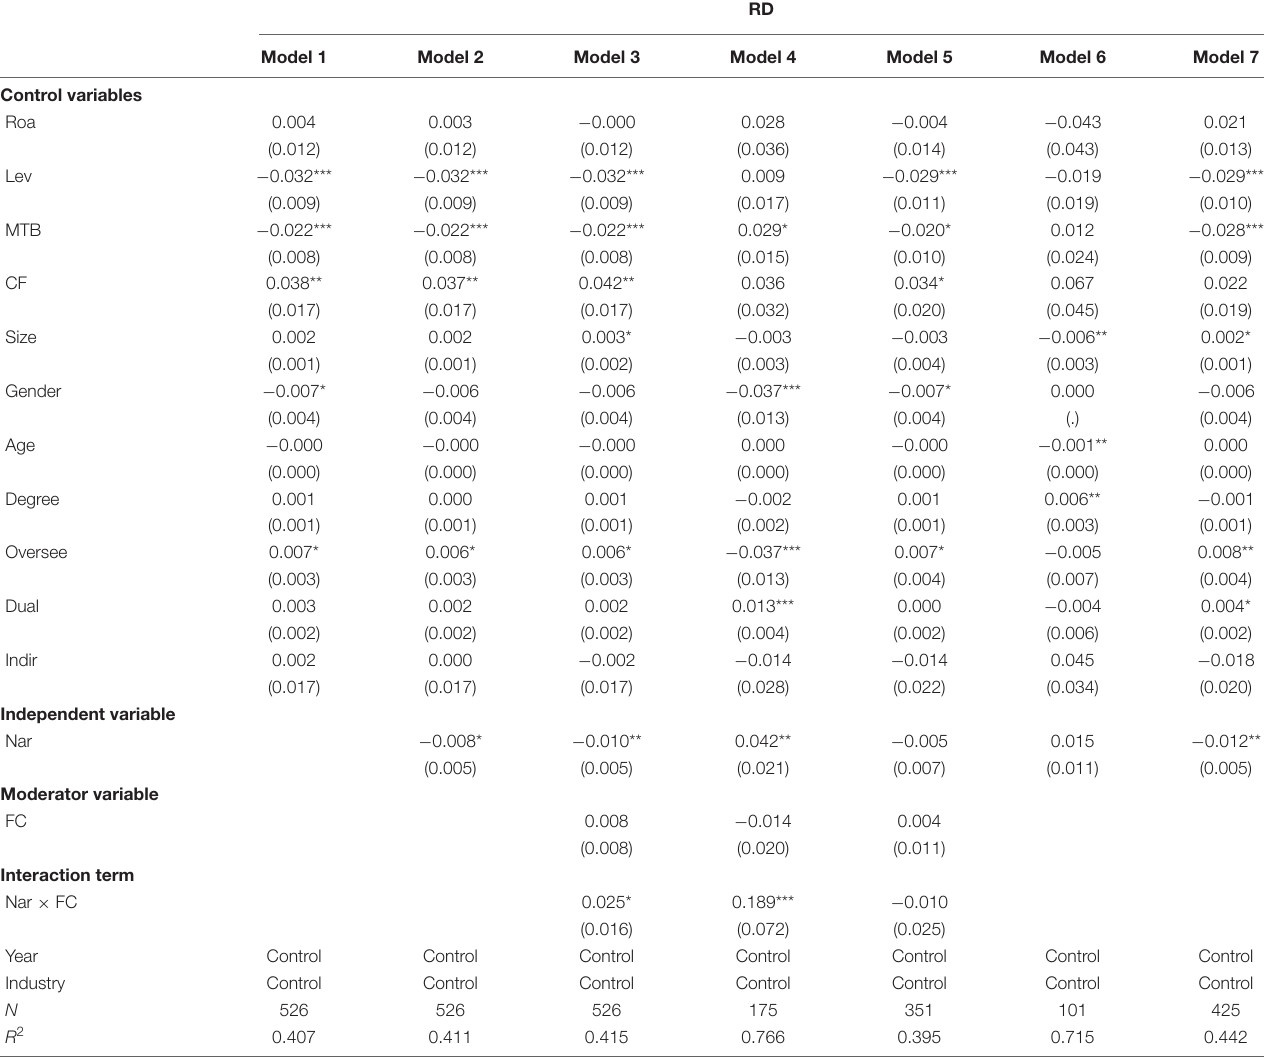
TABLE 5 | Regression analysis